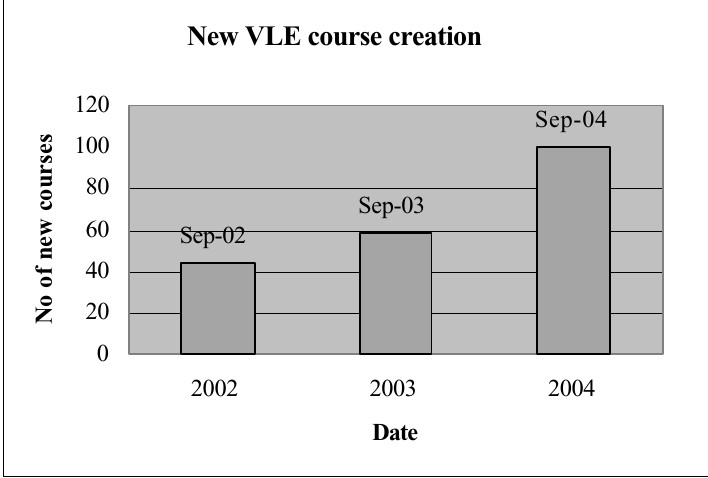
Figure 4. Number of new courses created on the institutional